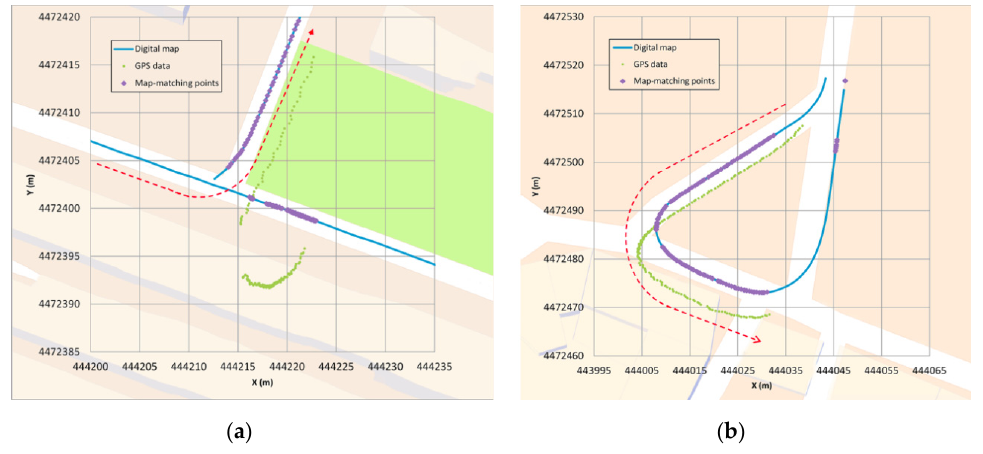
Figure 7. Type II error examples. ( a ) T-junction, ( b ) V-junction.